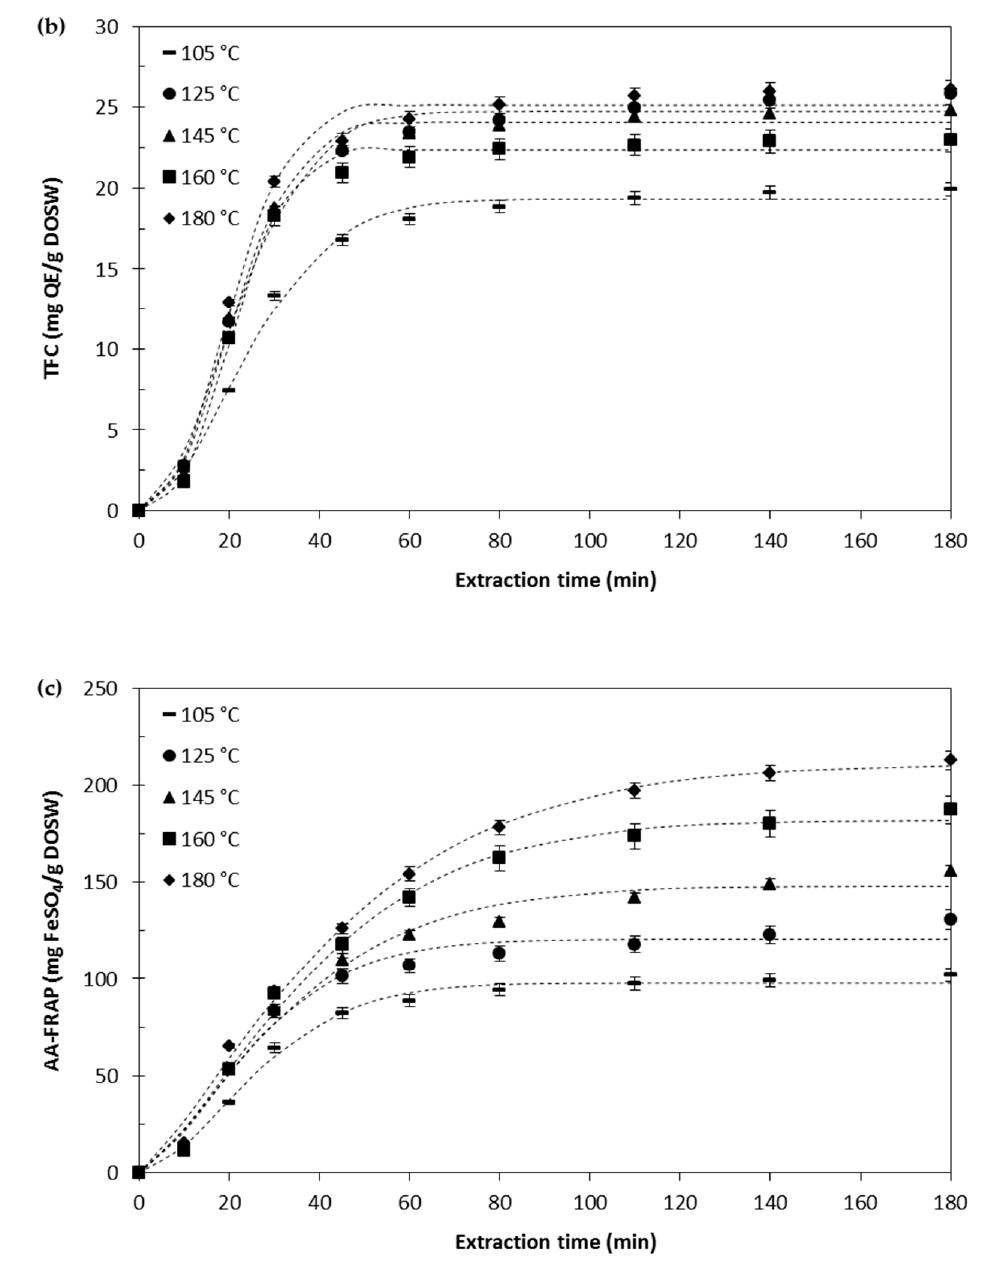
Figure 3. Accumulated extraction curves at different temperatures for TPC ( a ), TFC ( b ), and antioxidant activity ( c ) obtained from onion skin wastes at 2.5 mL/min and 5 MPa. Dashed lines represent the extraction curve obtained with the Weibull model.